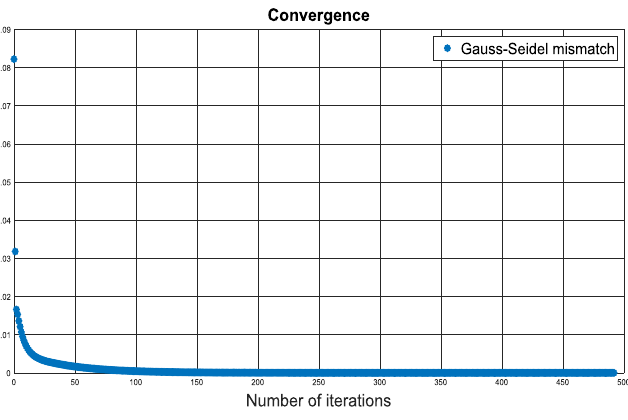
Figure 7. Convergence of Gauss-Seidel method (IEEE-30 bus)